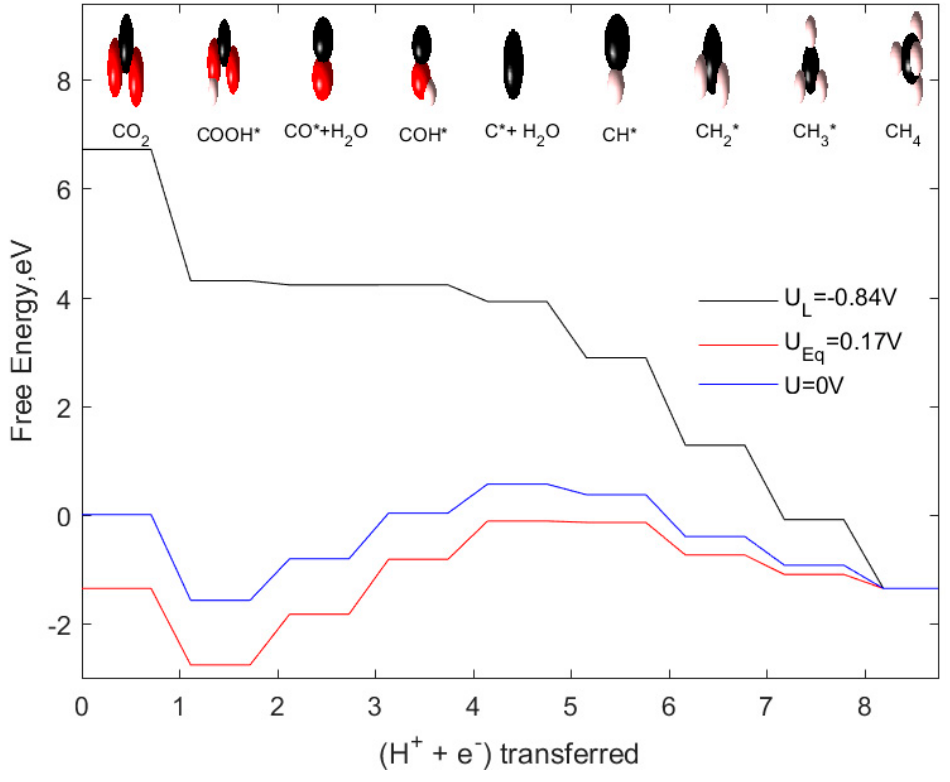
Figure 7. Reaction energy profiles for CO 2 reduction to CH 4 at 0V vs. RHE (blue), thermodynamic limiting potential (U L ) of − 0.84 V vs. RHE (black) and equilibrium potential (U E ) of 0.17 V vs. RHE (red). Color code of atoms: red: oxygen, black: carbon, white: hydrogen. 2.5. Comparison of CO 2 Reduction to CH 4 and CH 3 OH on Graphene Supported WC Nanocluster and WC